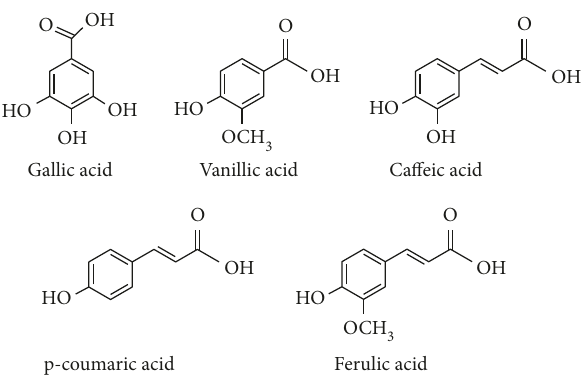
Figure 3: Molecular structures of studied phenolic acids.